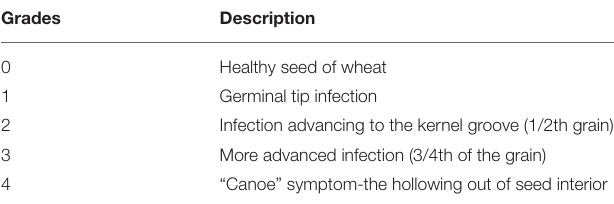
TABLE 1 | grades given to Karnal bunt infected wheat